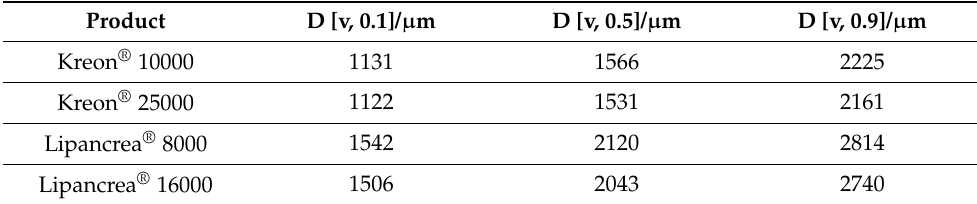
Figure 1. Kreon ® and Lipancrea ® particle size: ( A ) Kreon ® (left) and Lipancrea ® (right) scanning microscope image; ( B ) Kreon ® (left) and Lipancrea ® (right) light microscope image; ( C ) particle size analysis. Table 2. Kreon ® and Lipancrea ® particle size.